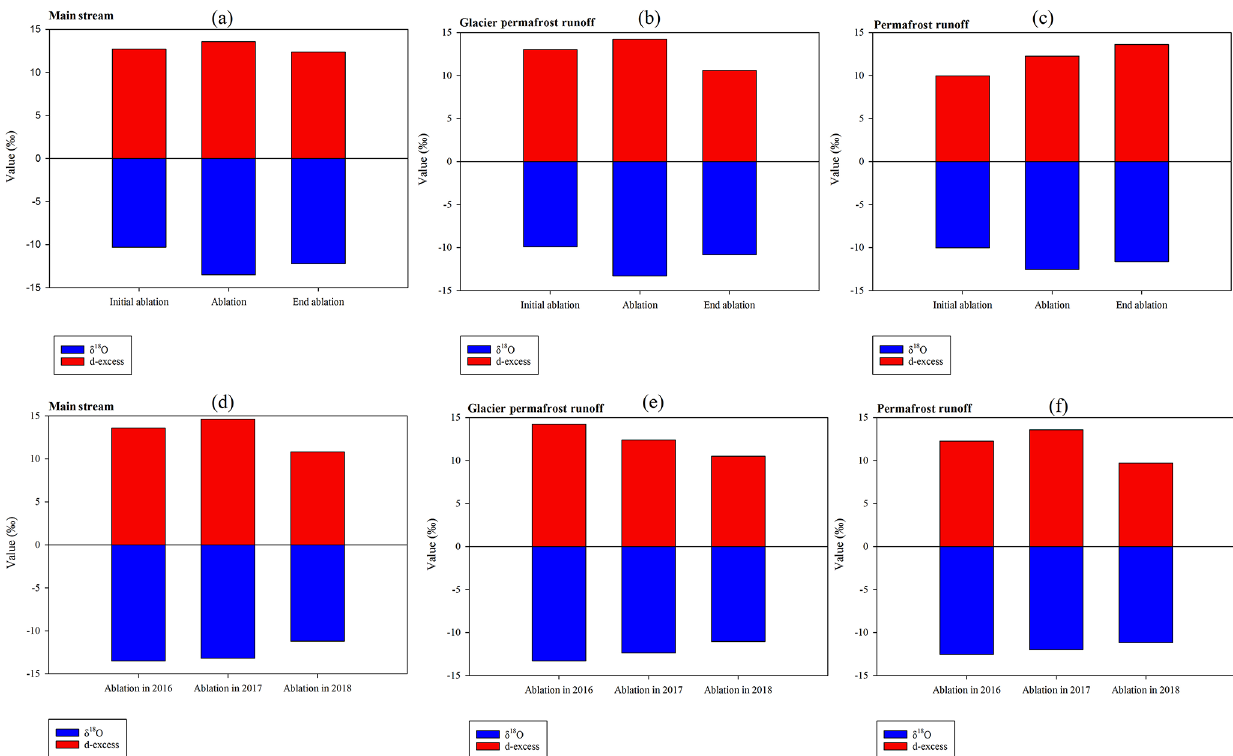
Figure 2. Temporal variation in δ 18 O and d -excess during the sampling period in the study area. (This figure mainly shows the temporal variation in δ 18 O and d -excess for different types of runoff based on different ablation in 2016 and strong ablation from 2016 to 2018; a – c shows the change of δ 18 O and d -excess in different ablation periods for the main stream, glacier and snow runoff, and river in permafrost area; d – f shows the change of δ 18 O and d -excess in the ablation period from 2016 to 2018 for the main stream, glacier and snow runoff, and river in permafrost